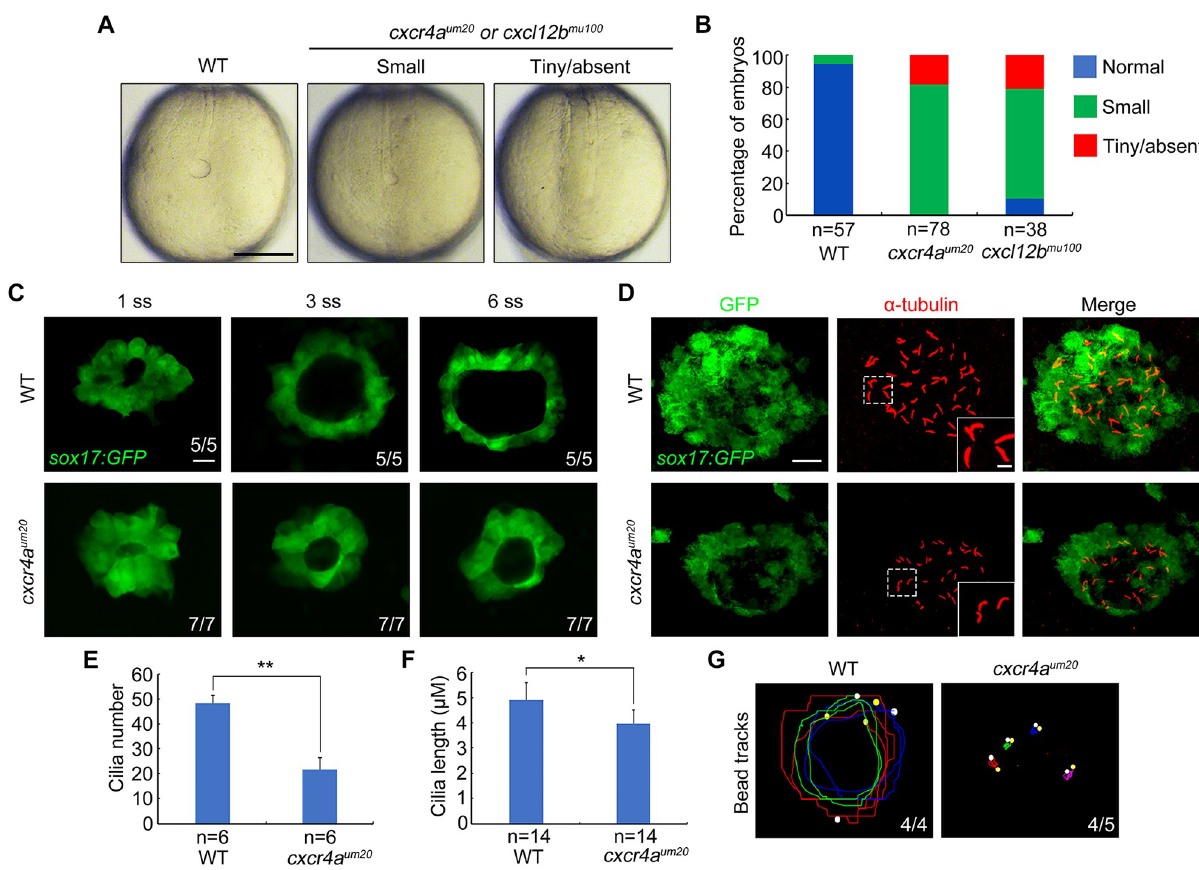
Fig 2. cxcr4a is indispensable for KV formation and ciliogenesis. (A–B) Light micrographs at the 10-somite stage showed smaller or even absent KVs in cxcr4a um20 or cxcl12b mu100 mutants. Scale bar, 200 μ m. Embryo ratios with different KV sizes were shown in (B). Underlying data can be found in S1 Data. (C) Time-lapse confocal images from the 1-somite stage to the 6-somite stage showed the dynamic formation of KV in WT and cxcr4a -deficient Tg(sox17 : GFP) embryos. Scale bar, 20 μ m. The ratios of affected embryos were indicated. (D–F) Fluorescent immunostaining of KV using anti-GFP and anti- α -Tubulin antibodies at the 10-somite stage in WT embryos and cxcr4a um20 mutants. The boxed areas in the images were presented at higher magnification in the relevant insets. Scale bar, 20 μ m. Cilia average number and length were quantified from three independent experiments, and the group values were expressed as the mean ± SD (E and F). Student t test, � P < 0.05, �� P < 0.01. Underlying data can be found in S1 Data. (G) Fluorescent bead tracking experiments showed that fluorescent beads moved in a persistent counterclockwise fashion in WT embryos but had no directional flow in cxcr4a um20 mutants. White spots, yellow spots, and curves mark the start points, the end points, and the tracks of bead movements, respectively. GFP, green fluorescent protein; KV, Kupffer’s vesicle; sox , SRY-box transcription factor; Tg , transgene; WT, wild-type; α -Tubulin, acetylated tubulin.